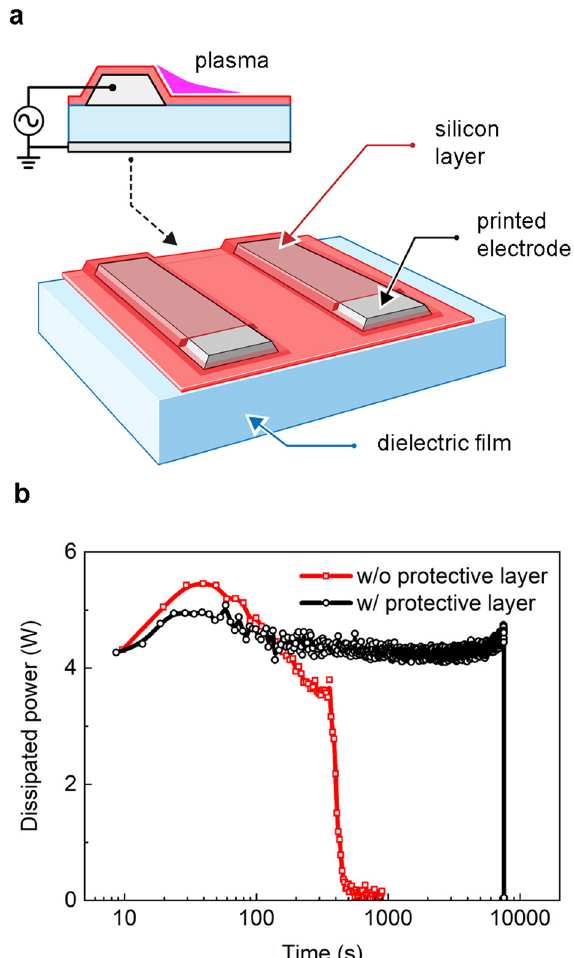
Figure 4. ( a ) Schematic view of a silicon-coated FXDBD source. ( b ) Dissipated power of FXDBD with and without electrode